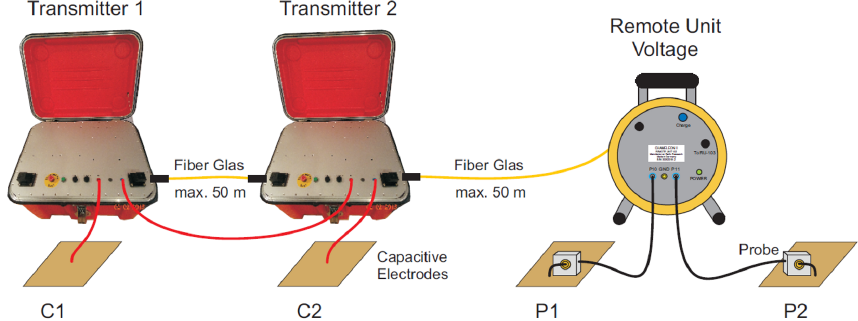
Figure 2. Arrangement of the components of the Chameleon II measuring system for capacitive and galvanic impedance measurements. The red lines are analogue current cables. There is one transmitter at each current electrode. The remote unit, integrated in a cable drum, is connected to the potential electrodes via active probes and potential cables (black). Optic fibre cables (yellow) are used to avoid coupling effects. (Radic Research: Flyer Chameleon